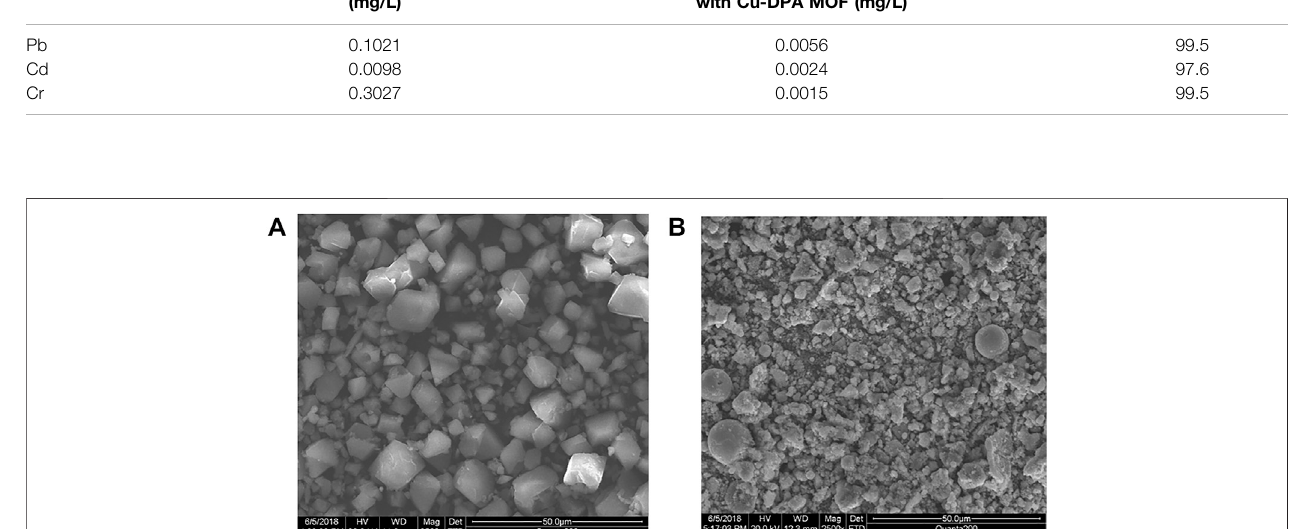
TABLE 4 | Removal of Pb, Cd, and Cr from real water samples collected from the car wash Labajo area using Cu-DPA MOF at optimized conditions. Metal Concentration before treatment